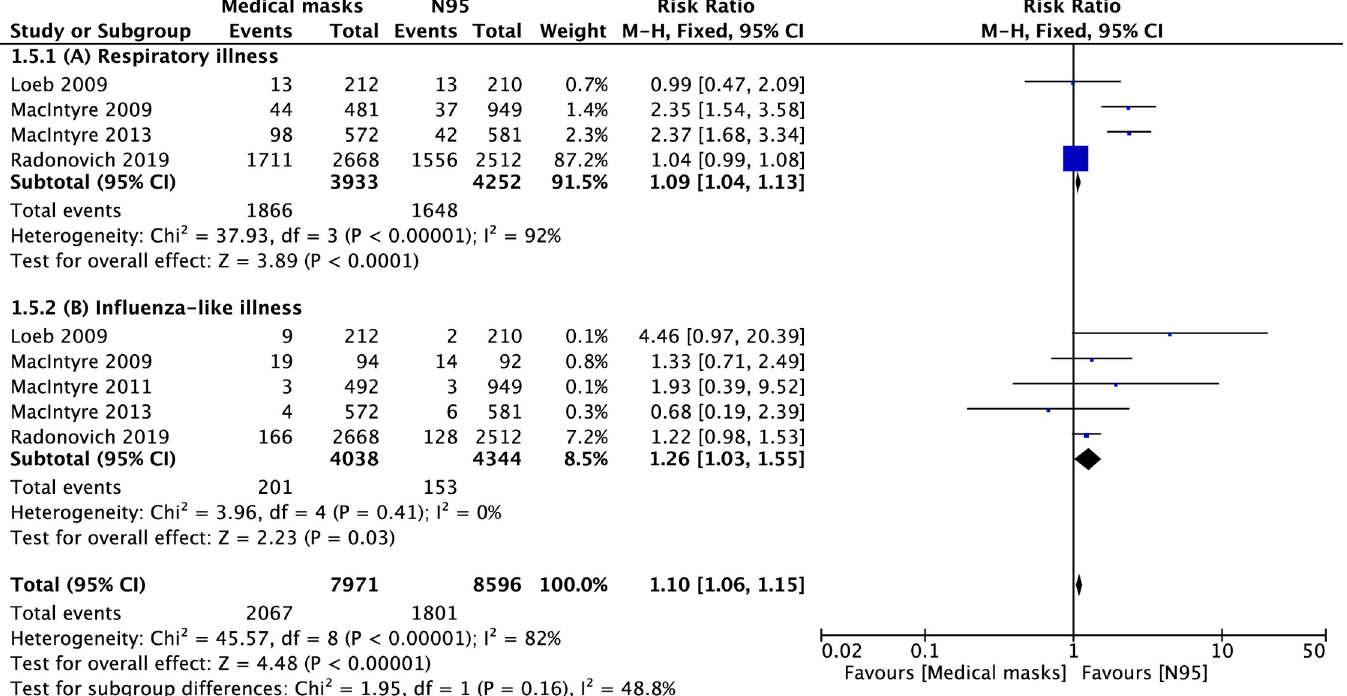
Fig 4. Forest plot of secondary outcomes in medical masks vs. N95 groups : (4A) respiratory-like illness; (4B) influenza-like illness. The center of each square represents the weighted mean difference for individual trials, and the corresponding horizontal line stands for 95% confidence interval. The diamonds represent pooled results.